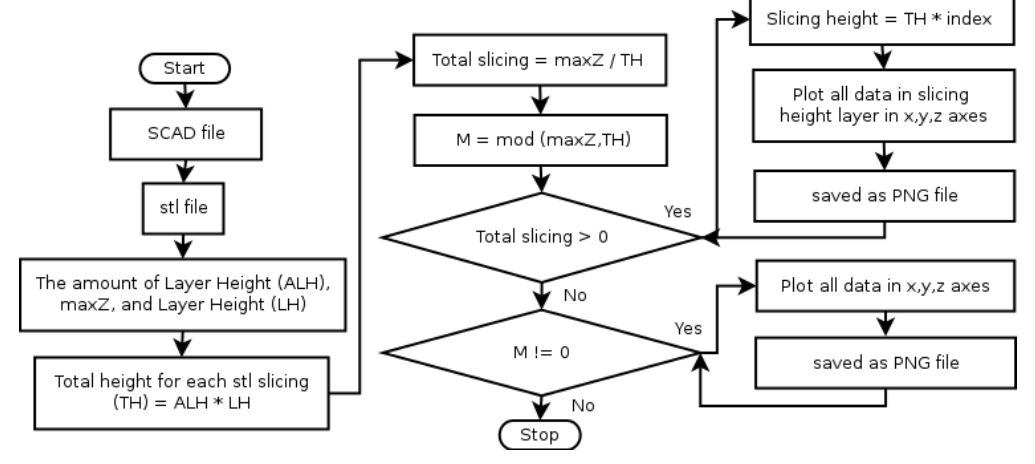
Figure 5. Slicing stl file flowchart.